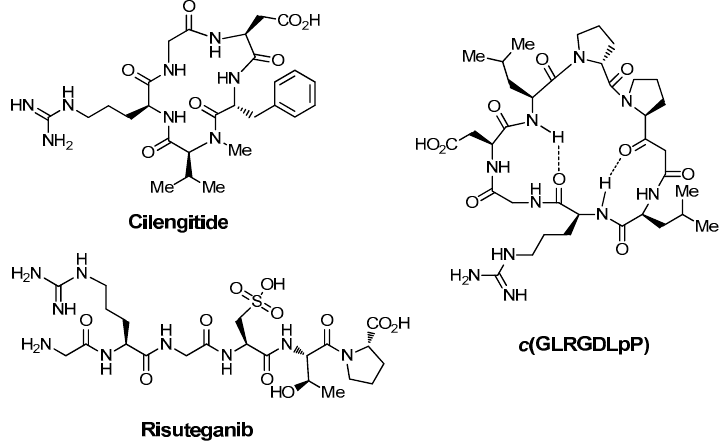
Figure 1. Biologically active compounds based on the RGD motif.